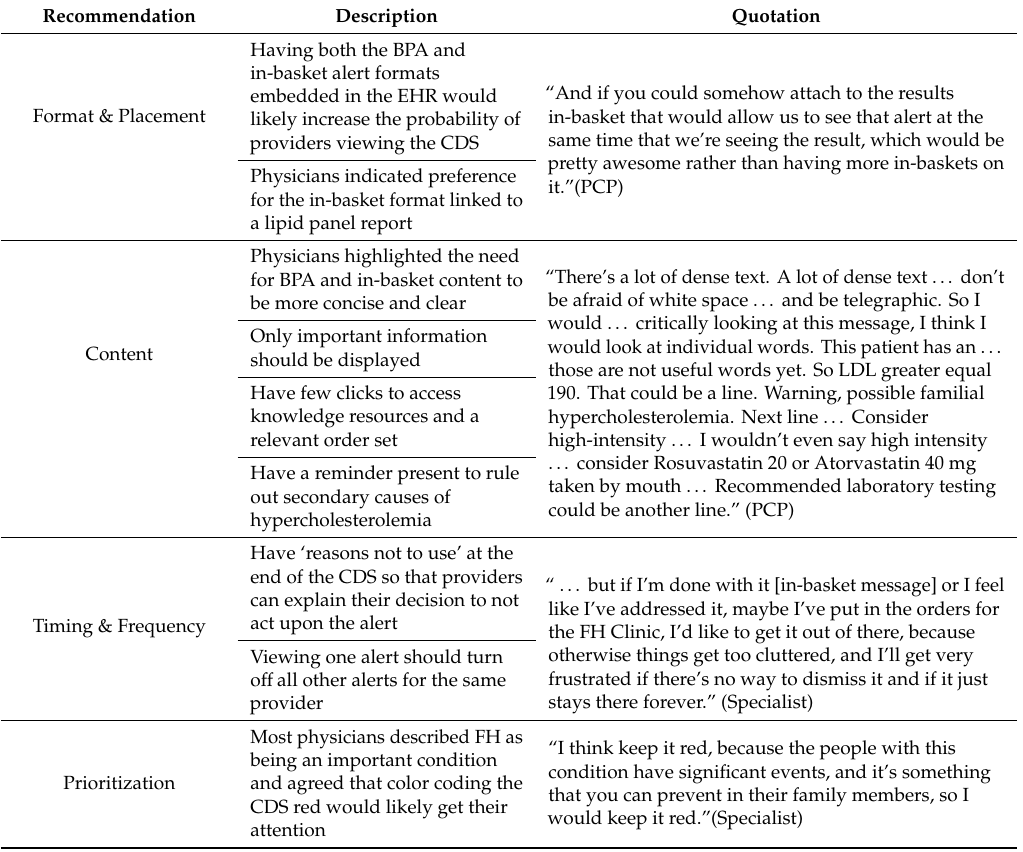
Table 3. Usability recommendations with corresponding descriptions and representative quotations highlighted from usability testing with